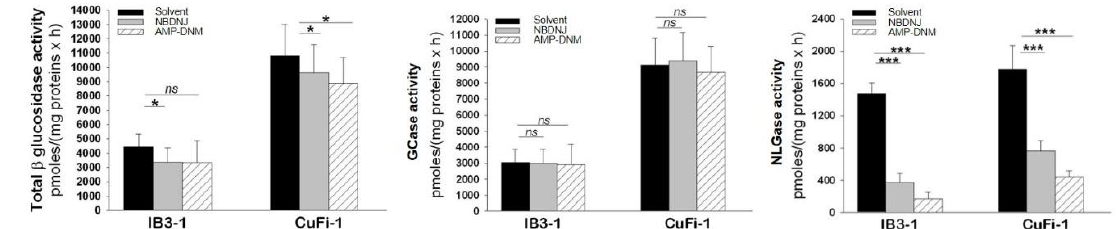
Scheme 11. Synthetic route to AMP-DNM [69,70].